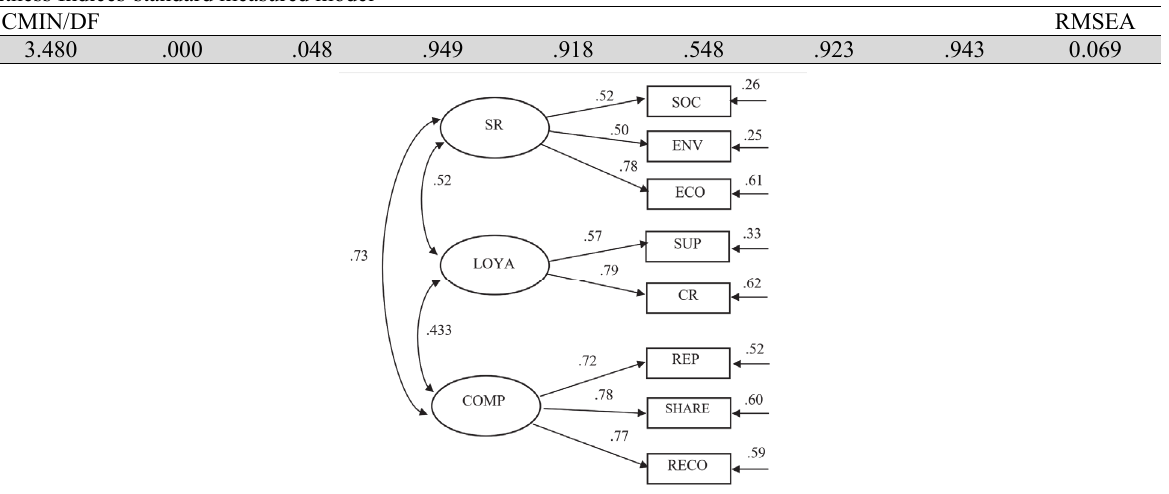
Fig. 2. The standard measurement of research model